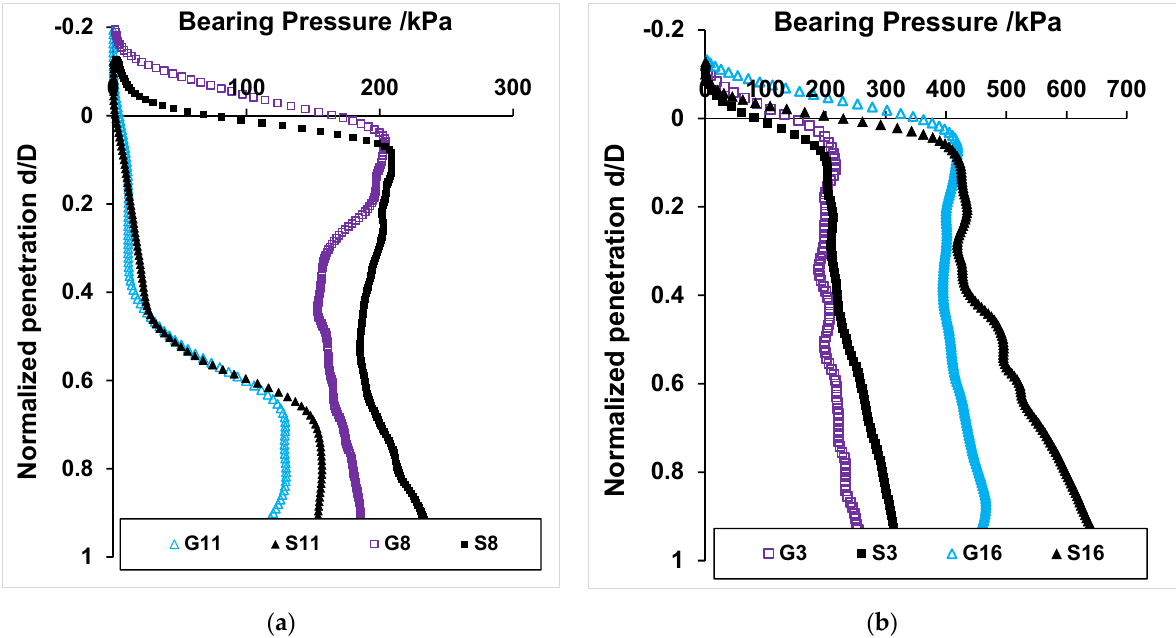
Figure 5. Comparison of resistance profiles of generic and cubic spudcans: ( a ) test T1 and FS13; ( b ) test H3C14 and D1SP70a.